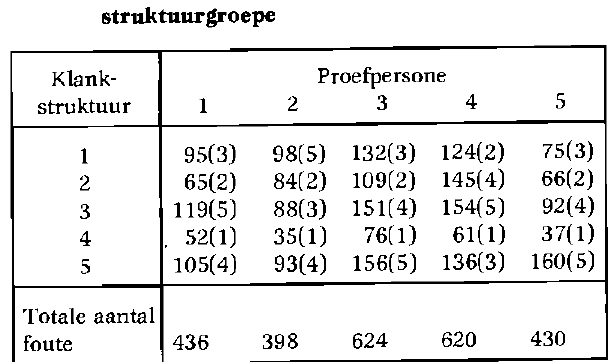
Tabel 4: Totale getal ouditief waarneembare foute